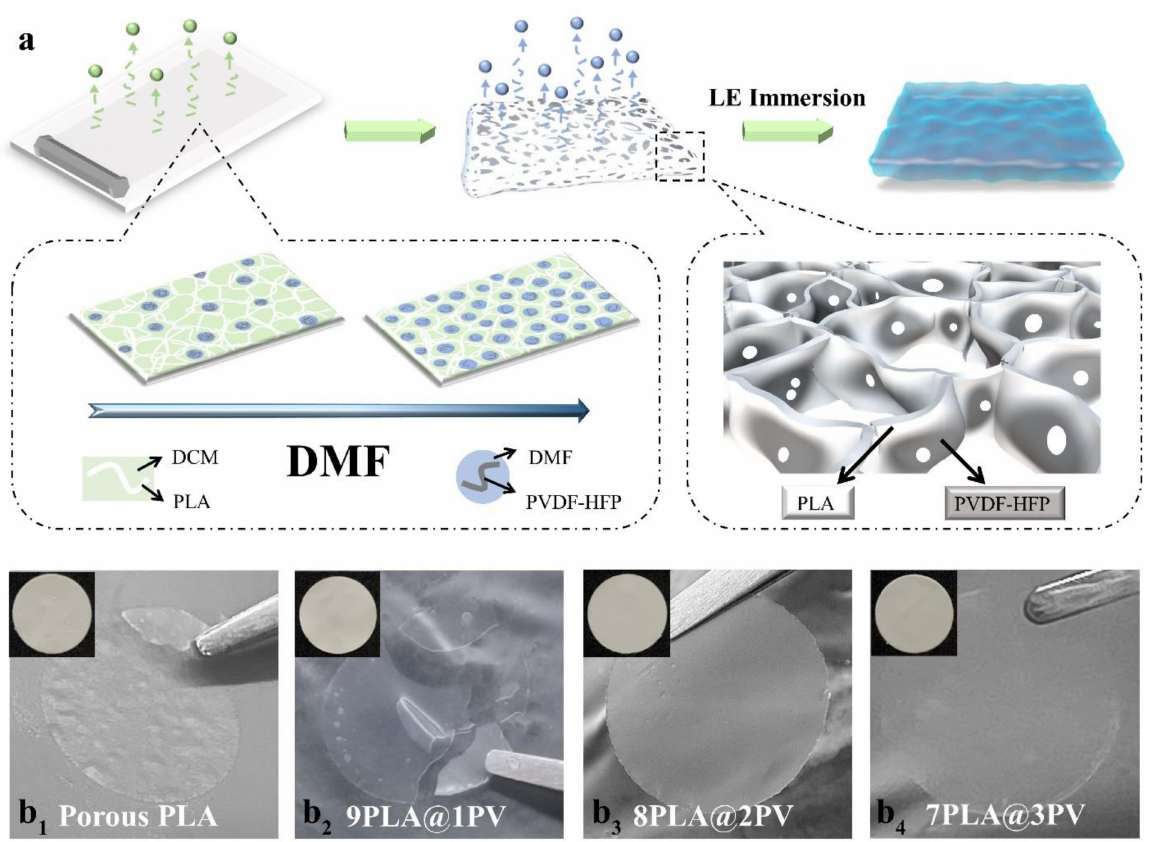
Figure 1. ( a ) Schematic illustration for the preparation of GPE, ( b 1 – b 4 ) the digital graphs of the GPEs with different PVDF-HFP